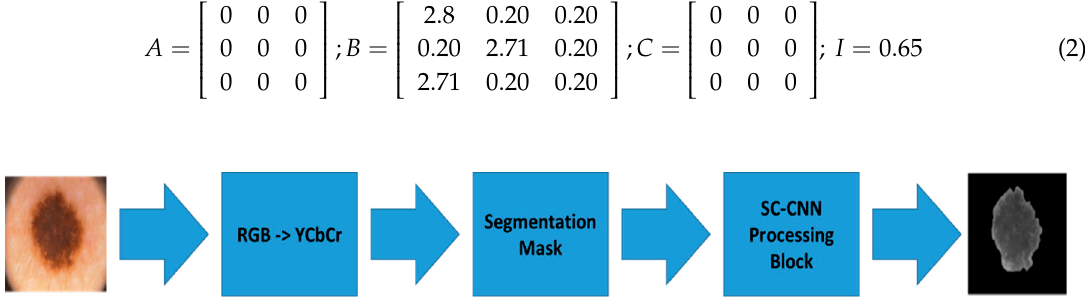
Figure 3. The pre-processing block based on SC-CNNs.